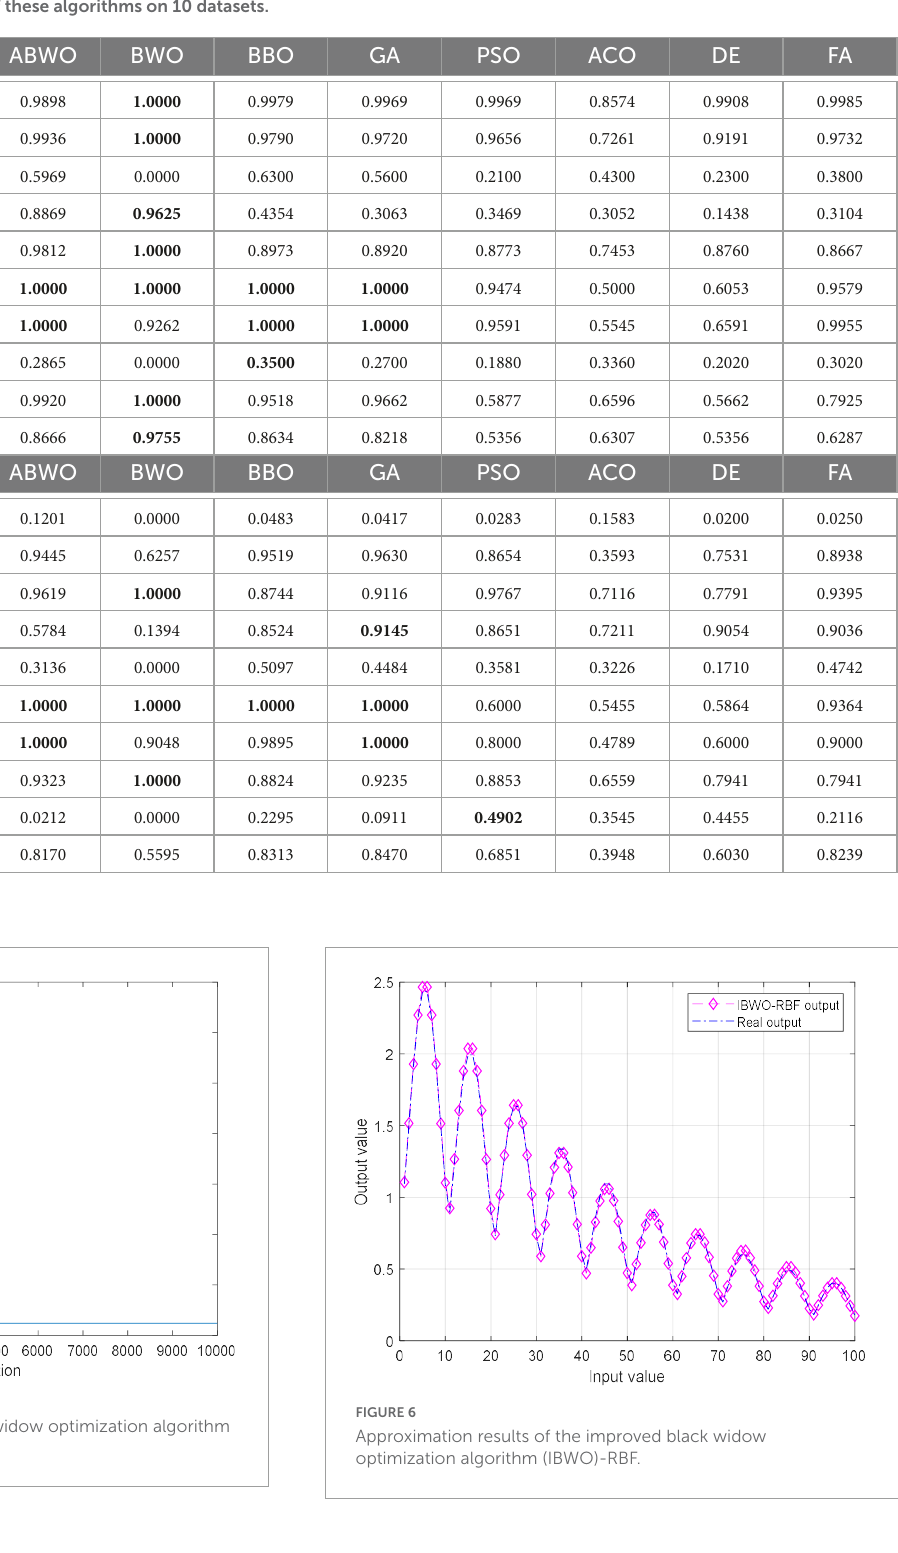
TABLE 5 Sensitivity and specificity of these algorithms on 10 datasets.